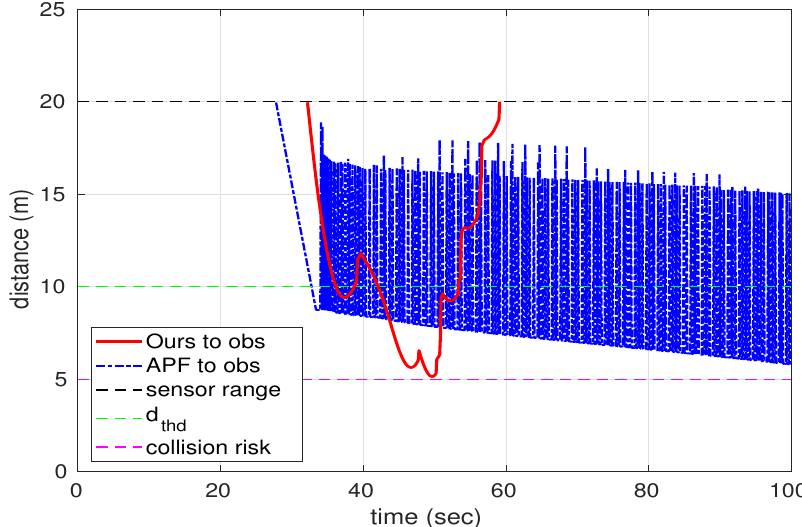
Figure 6. Relative distance to the nearest obstacle in the local minima problem